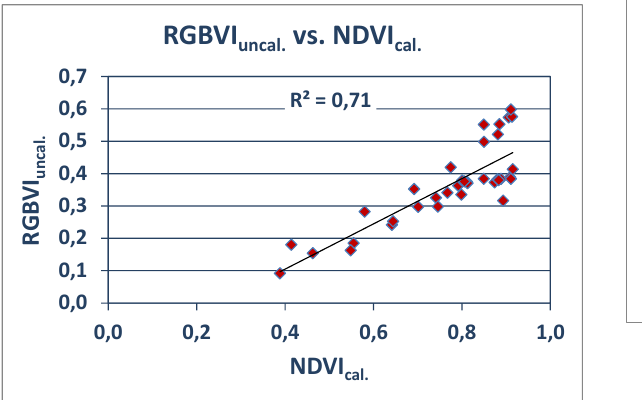
Figure 4. Evaluation of the RGBVI uncal. vs. NDVI cal. for the N experiment